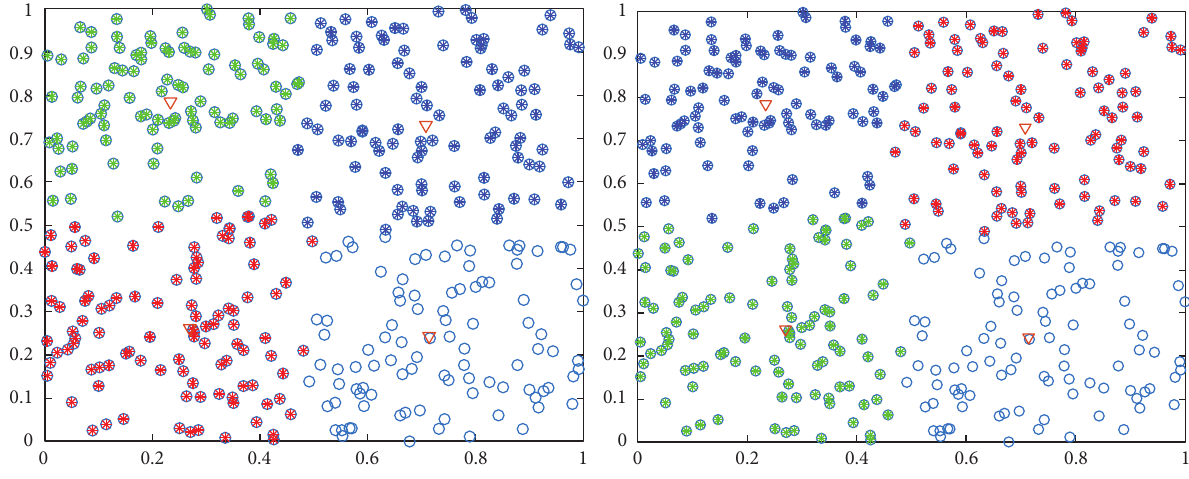
Figure 2: Clustering results of different initial